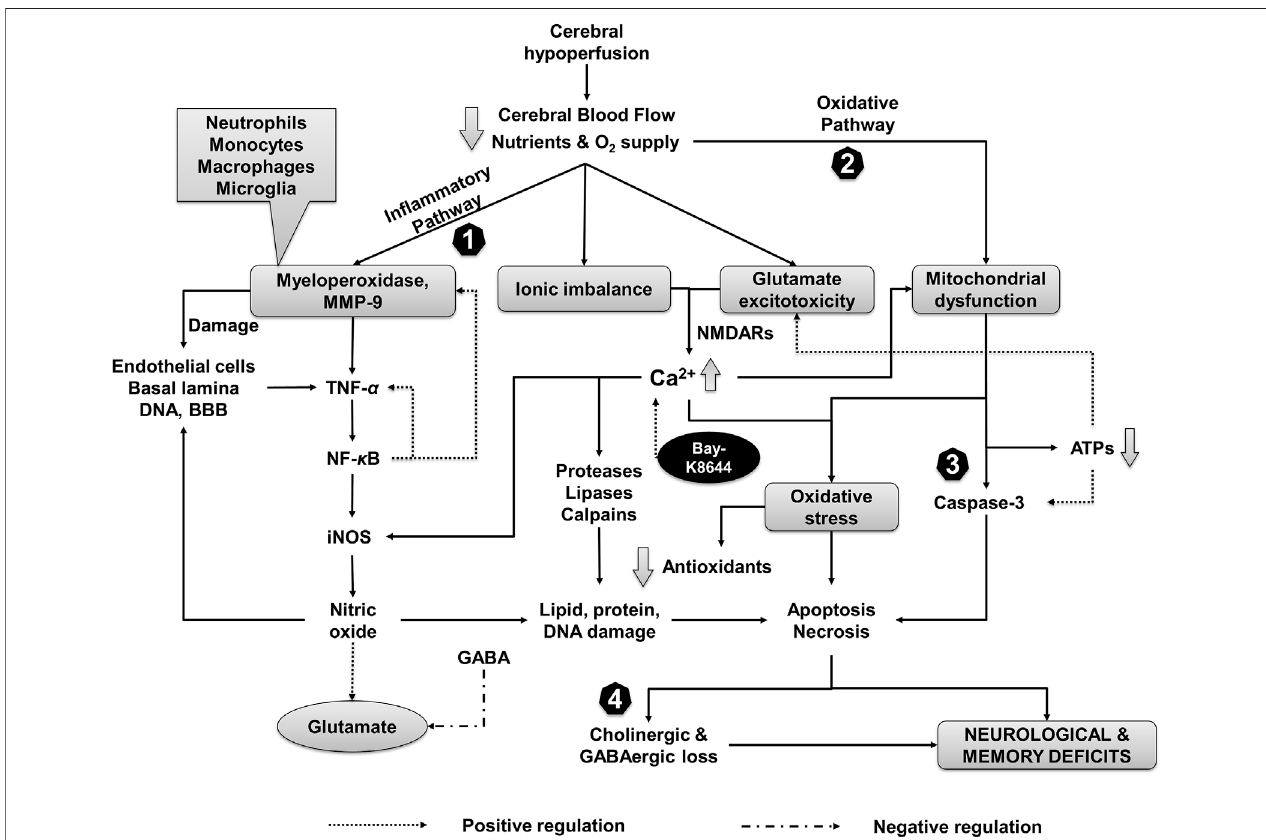
FIGURE9| Events associatedwith CH injuryand putative neuroprotective mechanism ofCuE. In fl ammation,oxidative stress, and ionin fl uxare theprimary events associatedwith reducedCBF followed byderangement ofneurotransmitters. CH recruit MMP-9and myeloperoxidase leadingtosequential activationofTNF- α ,NF- κ B, and iNOS. CH-induced formation of reactive oxygen species and mitochondrial dysfunction leads to decline of endogenous antioxidants and damage to biomolecules (e.g.,lipids,proteins,geneticmaterial).Adecreaseinadenosinetriphosphates(ATPs)furtherpotentiatestheglutamatetoxicityandactivatesapoptoticandnecrotic pathways of cell death through caspases in the brain. Ionic imbalance and glutamate excess increase the intracellular calcium (Ca 2+ ) levels that aggravates oxidative stressandactivateproteases,lipases(e.g.,phospholipaseA 2 ),andCa 2+ dependentcalpains.ReductioninGABAergictransmissioninresponsetoCHpavesthewayfor undeterred glutamate excitotoxicity. CuE attenuates in fl ammatory cascade (1) and free radicals (2) that protect brain against proteolytic damage (3). Improvement in GABAlevels by CuE antagonizes the CH triggered glutamate toxicity (4) and enhances the cholinergic function in the brain against CH leadingto neuroprotective effects and improvement incognitivefunctions. Bay-K8644 (Ca 2+ agonist)canenhancetheCa 2+ -induced catastropheand antagonizethebrainprotectiveeffects ofCuEinCH rat